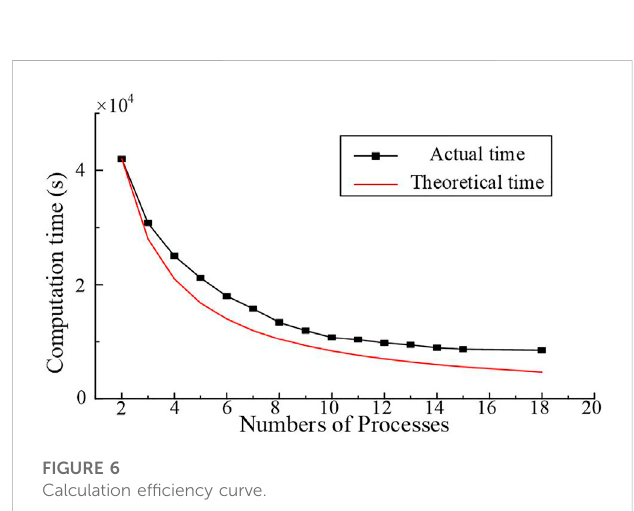
FIGURE 6 Calculation ef fi ciency